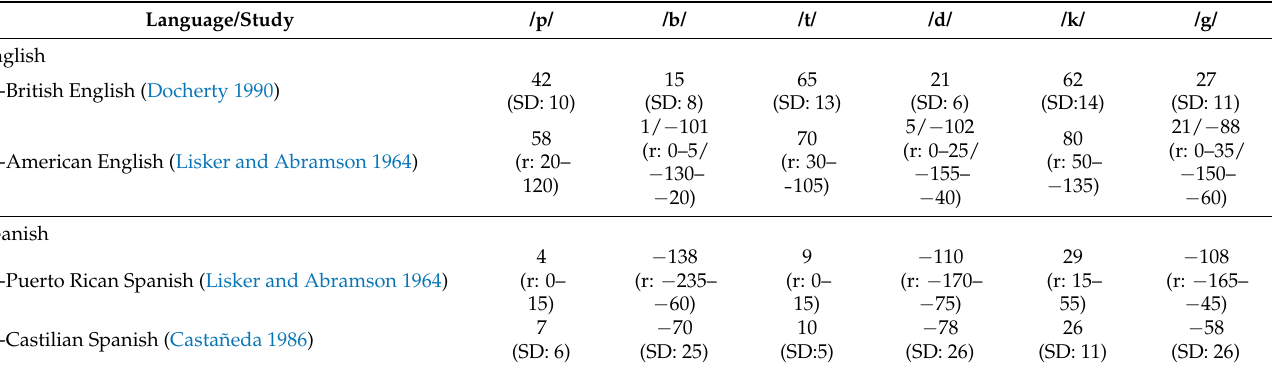
Table 1. Mean VOT values reported for English and Spanish stops by previous studies (SD = standard deviation; r =